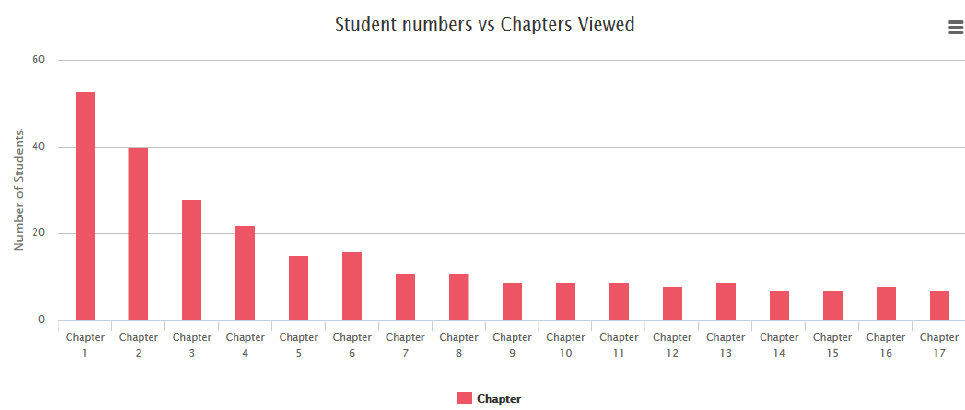
Figure 7. Student numbers vs chapters viewed